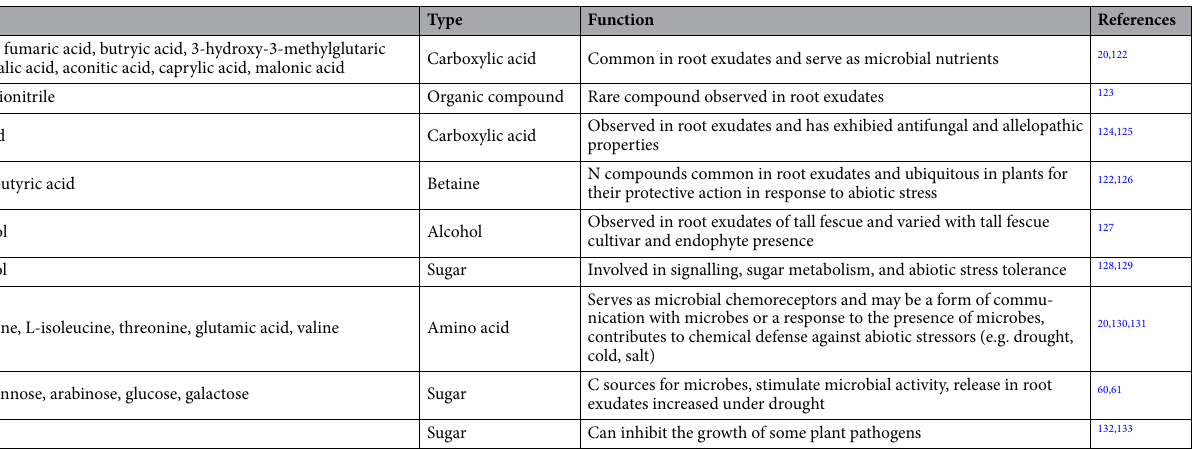
Table 2. Name, type, and function of root exudate compounds linked to drought severity treatment and to the separation of treatments A (control), B (mild), and C (severe) at T2 (after treatment). Compounds were identified with GC–MS (Figs. 4, S4, S5) and NMR (Figs. S6,